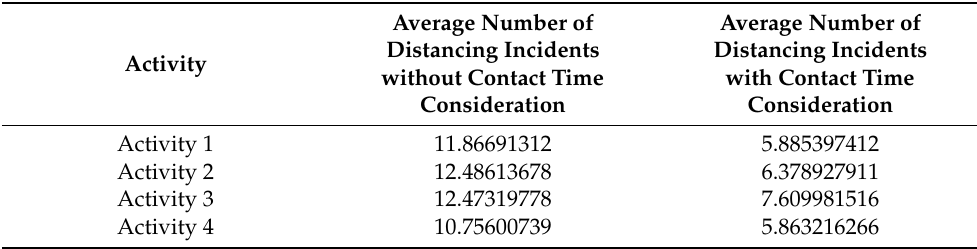
Table 4. Average number of distancing incidents without contact time consideration per activity, without contact time consideration.